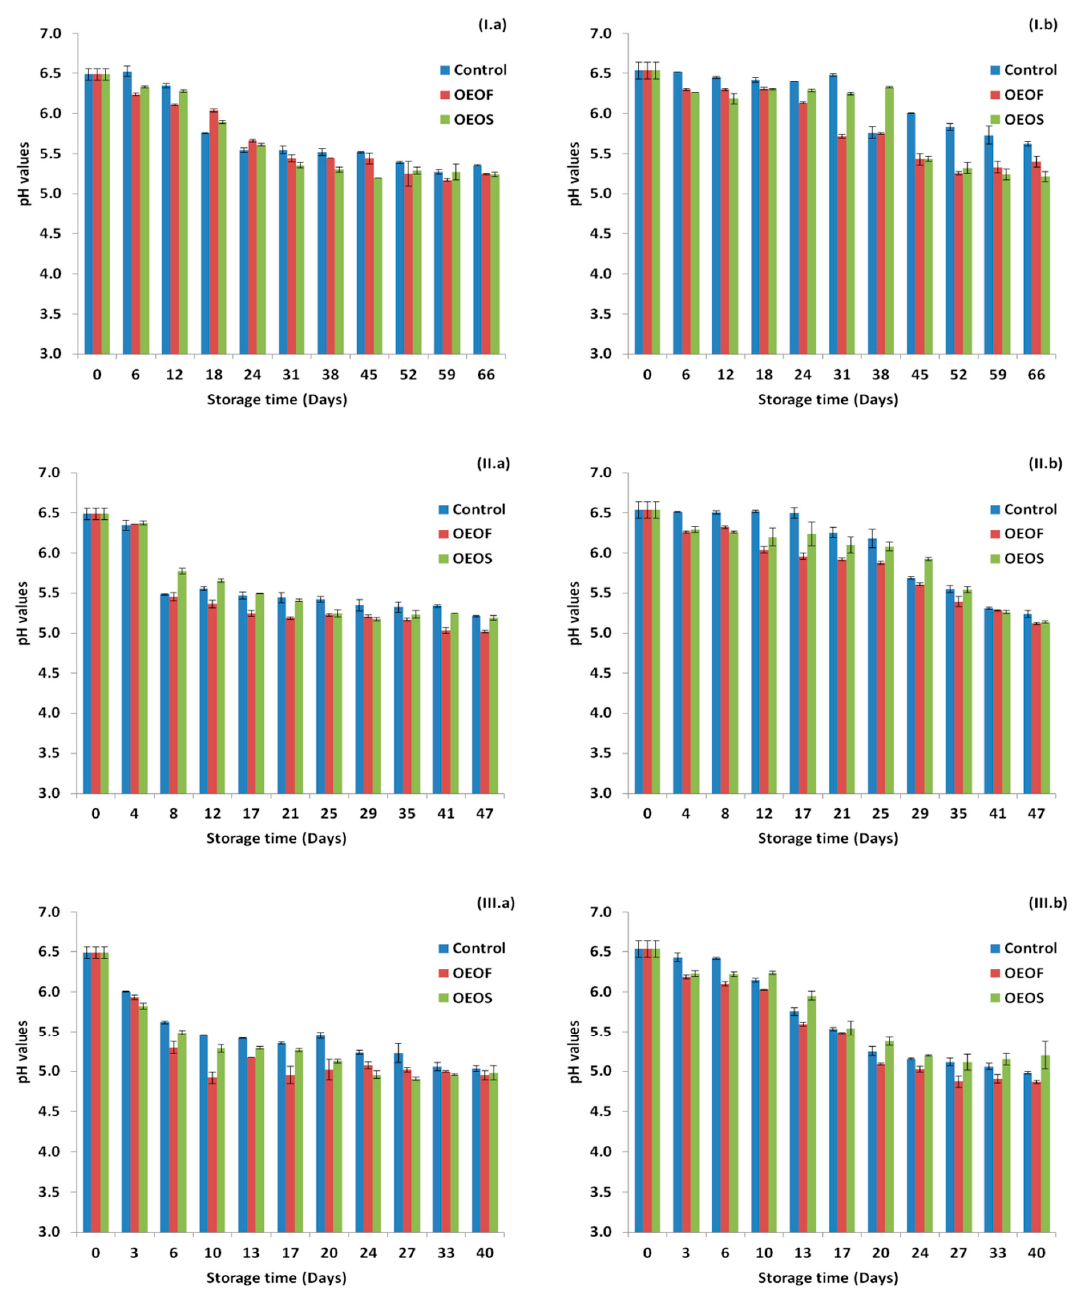
Figure 5. Changes in pH values for ham slices without ( a ) and after ( b ) high pressure processing treatment, during storage at 4 °C ( I ), 8 °C ( II ) and 12 °C ( III ). Values regarding control and OEOF samples (without essential oil), are common with those reported in our previous study [52].